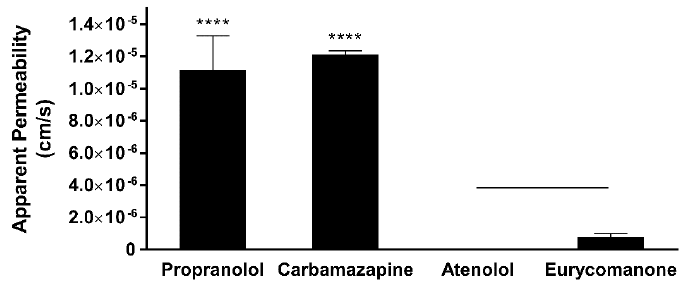
Figure 6. Eurycomanone showed low permeability as compared to propranolol and carbamazepine when assayed using the parallel artificial membrane permeability assay (PAMPA). The values were plotted based on the mean ± standard deviation. **** denotes significant difference when compared to eurycomanone ( p ≤ 0.0001). Line over bars indicates no significant difference between atenolol and eurycomanone ( p ≥ 0.05). Table 3. Apparent permeability of eurycomanone assayed via the Caco-2 permeability assay. Tested Compounds